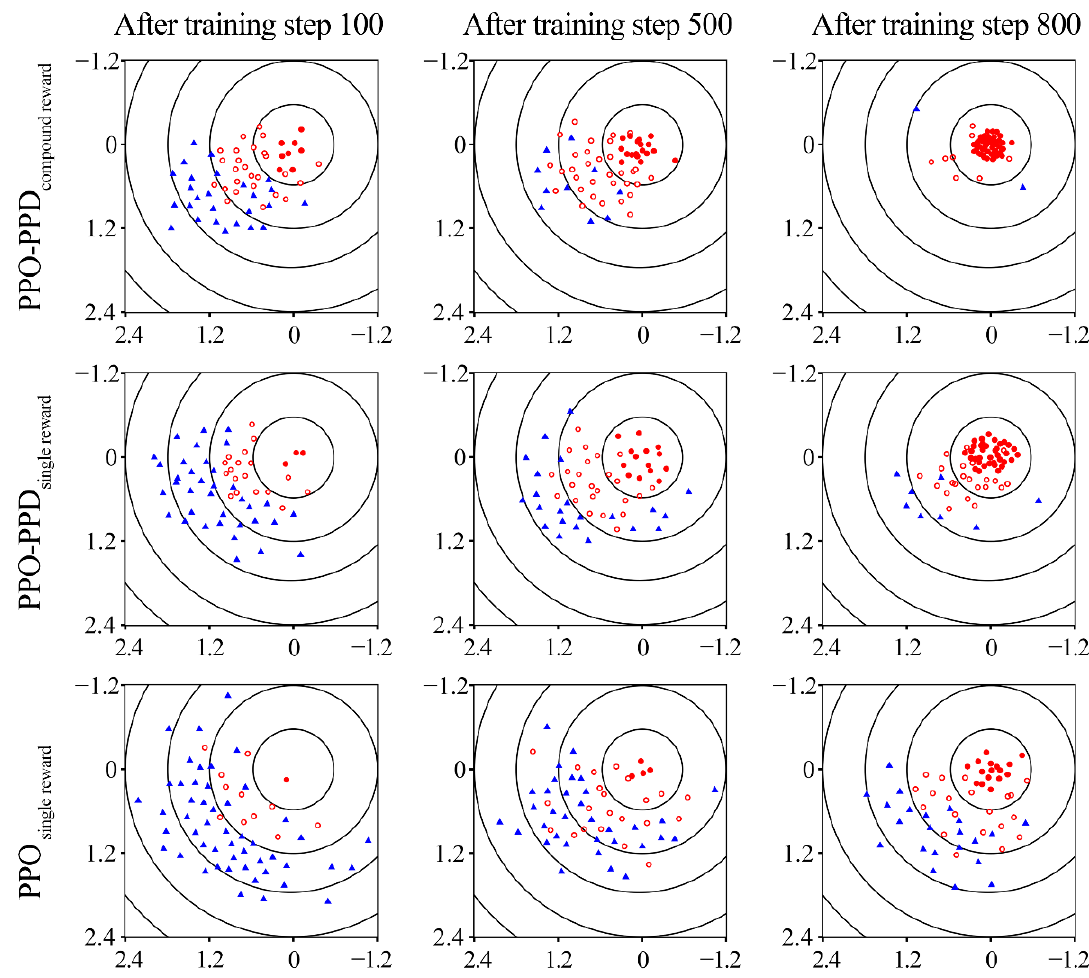
Figure 9. Performance comparison of control policies trained by PPO-PPD with compound reward, PPO-PPD with single reward and PPO with single reward. The circle indicates that the quadrotor successfully reached the target point stably. The non-filled circle indicates that the quadrotor is stable, but the target point was not found. The triangle indicates that the quadrotor is